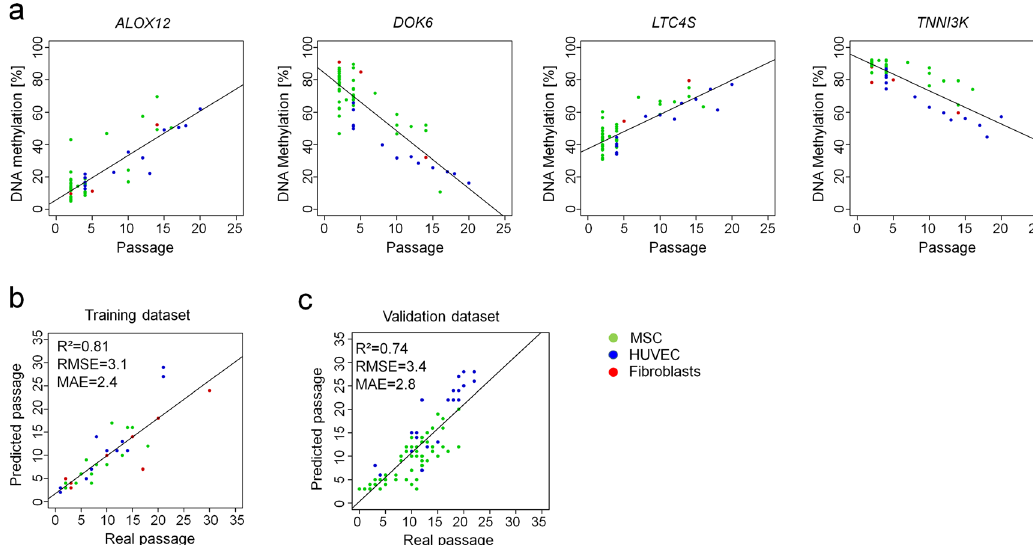
Fig. 1 DNA methylation changes during long-term culture. a Four CpGs were selected that revealed continuous changes during culture expansion in DNAm pro fi les of MSCs, fi broblasts, and HUVECs (all 450k BeadChip data, Supplemental Table S1). b DNAm at these four CpGs was then analyzed in a training set ( n = 44, Supplemental Table S4) by pyrosequencing and the results were used to train a multivariable model to estimate passage numbers (RMSE root mean squared error, MAE mean average error). c This predictor was validated on pyrosequencing results of an independent set of samples ( n = 83, Supplemental Data